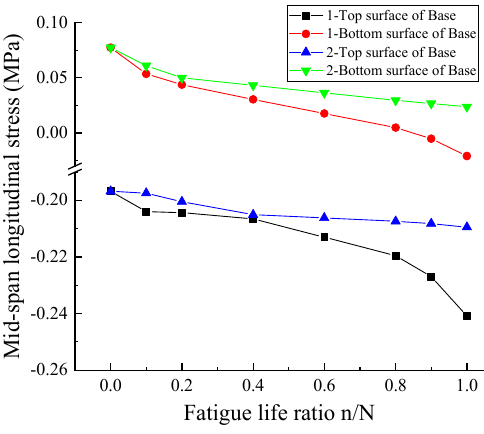
Beam Rail Figure 17. Mid-span deflection curve of beam and rail under fatigue load regardless of CA mortar layer damage. Table 8. Summary of beam and rail deflection variation. Structural Parts Initial Stage Displacement (mm) Structural Failure Deflection, Regardless of CA Mortar Layer Damage (mm)